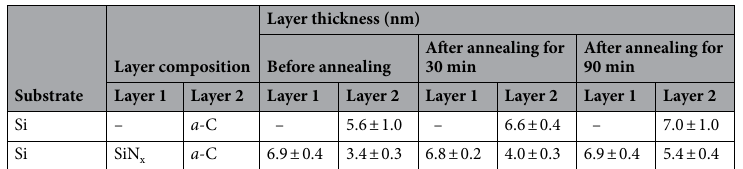
Layer Substrate